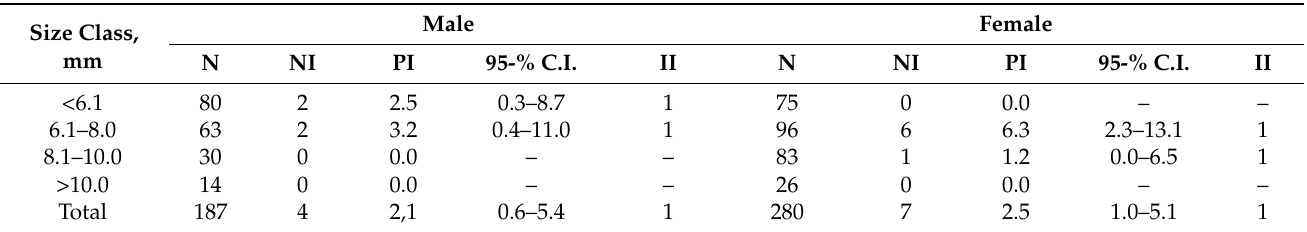
Table 1. Infestation indices of Hysterothylacium nematode larvae in crab-associated